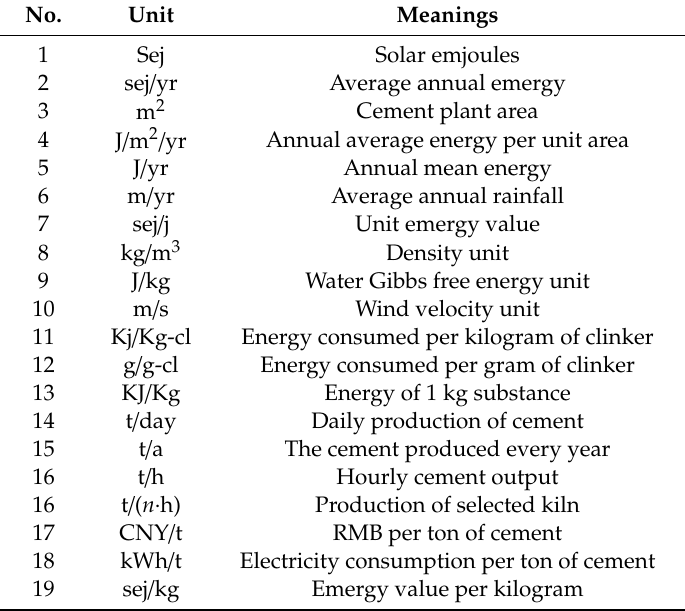
Table A1. Units used in this